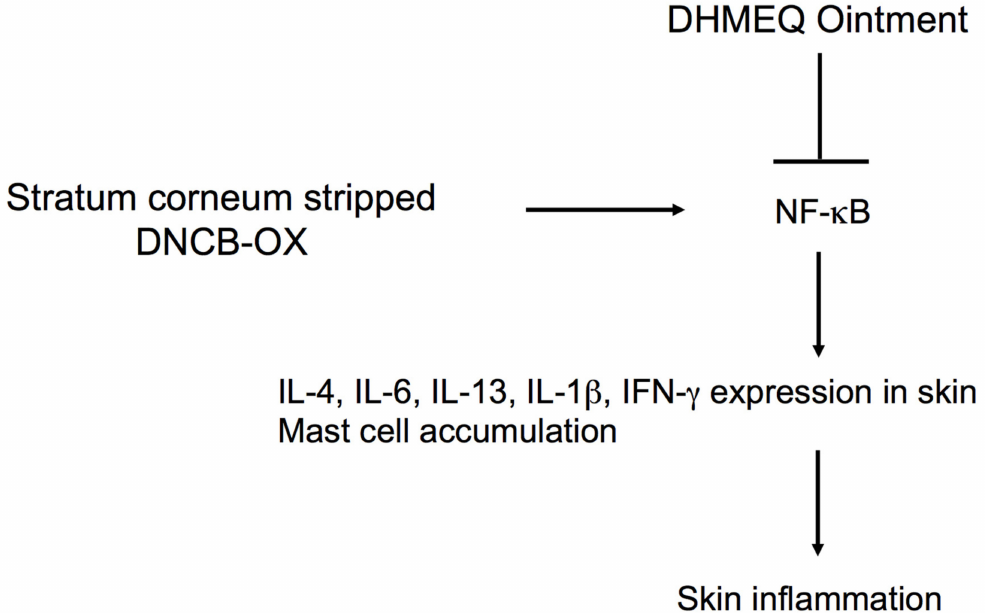
Figure 5. Inhibition of skin inflammation by DHMEQ ointment. DHMEQ directly inhibits NF- κ B of skin inflammatory